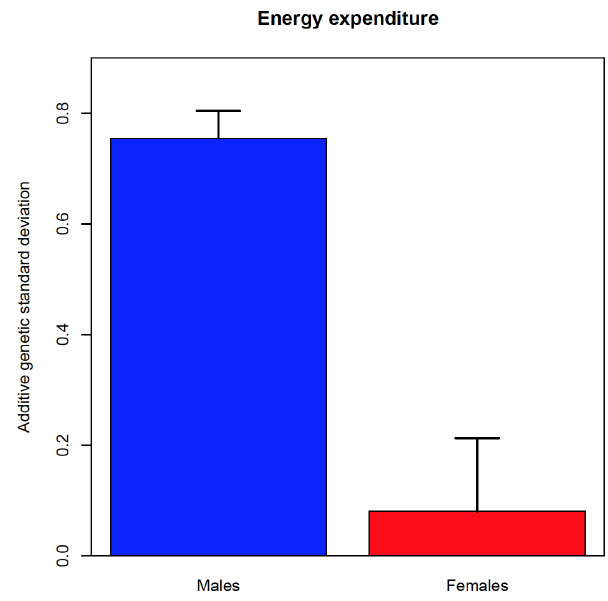
Figure 3. Genotype X Sex genetic variance for EEsed.